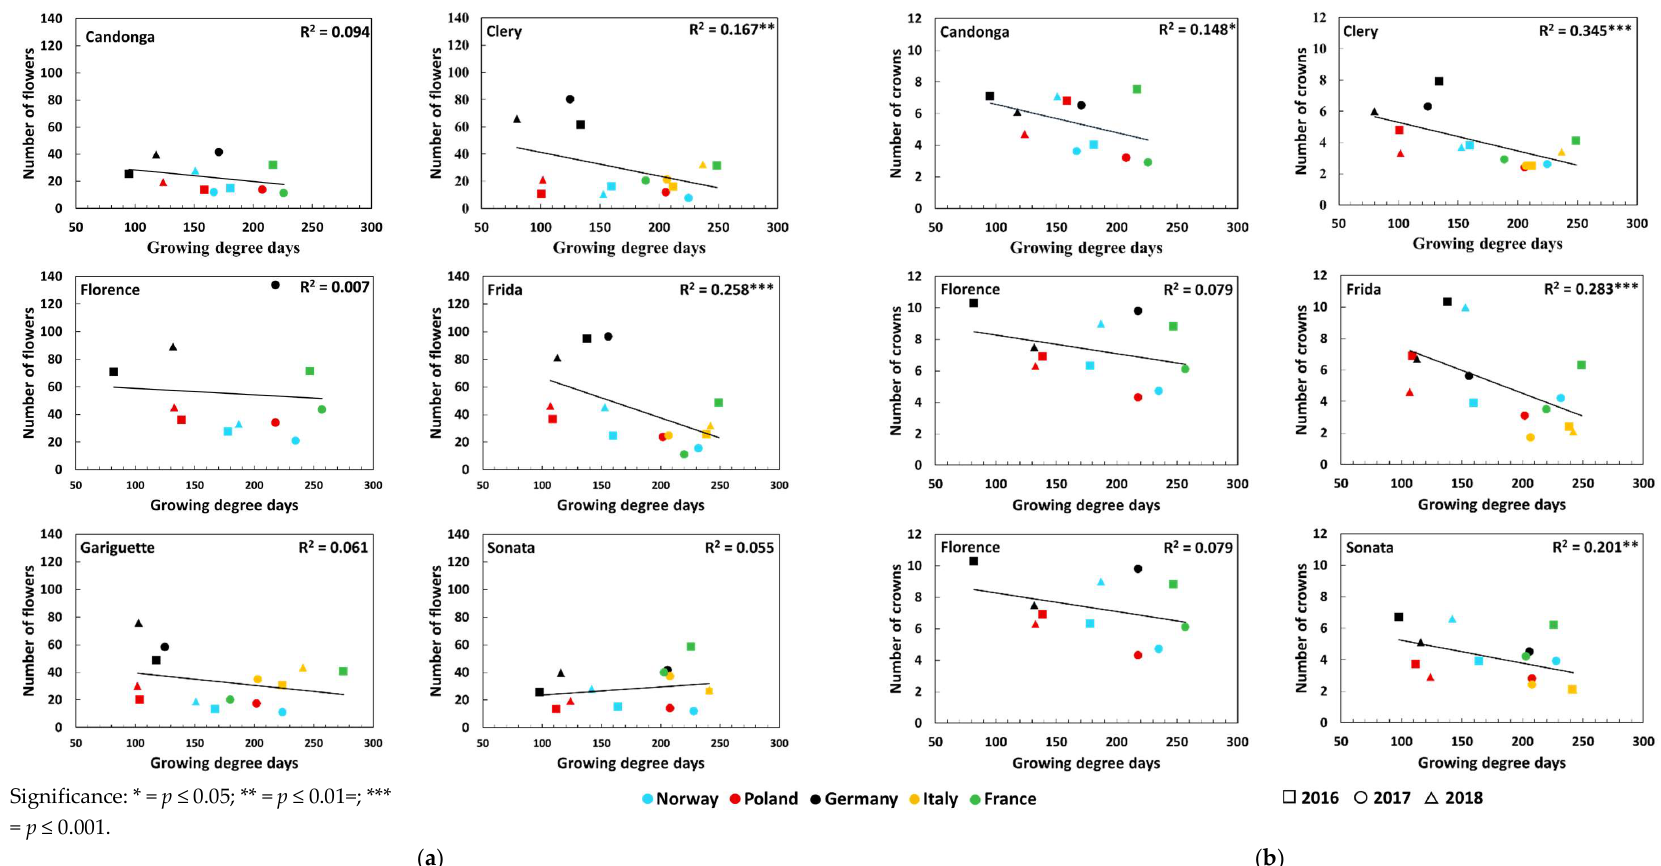
Figure 8. Number of flowers ( a ) and crowns ( b ) of six strawberry cultivars grown at five locations in Europe as influenced by the growing degree-day accumulation during the 3-week period preceding anthesis in spring in 3 years.